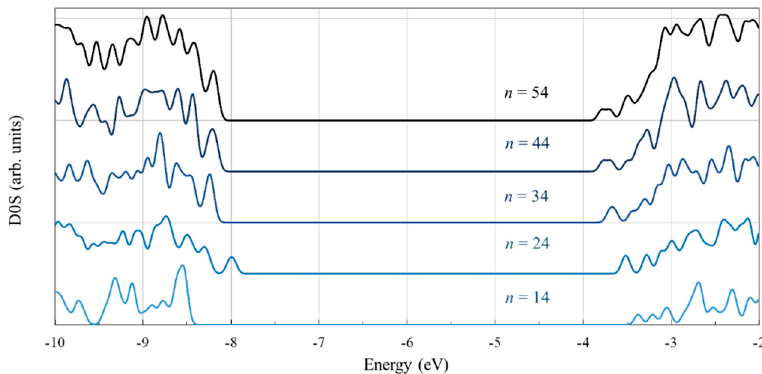
Figure 5. The density of states (in arbitrary units) of the Ti n O 2 n +2 H 4 clusters ( n = 14, 24, 34, 44, 54), calculated at the DFT/B3LYP/LANL2DZ level in water solvent. Energy levels were convoluted with Gaussian distributions with a full width at half maximum (FWHM) of 0.1 eV.